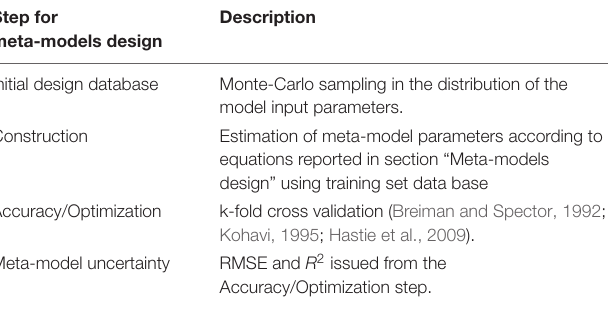
TABLE 1 | Steps for meta-models construction, validation and evaluation of the